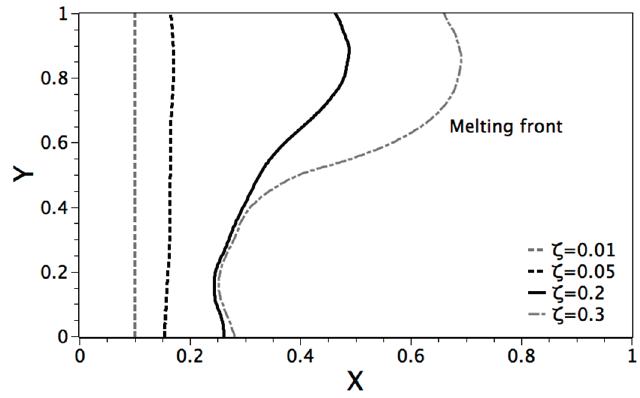
Figure 2. The average position evolution of the melting front versus ζ . Comparison with the results of [15,16].